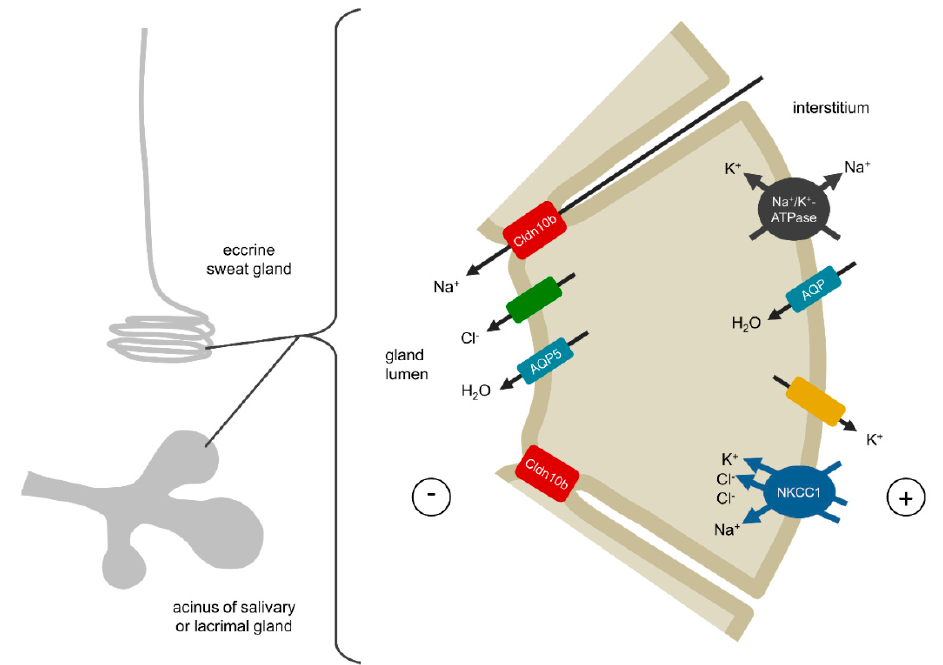
Figure 4. Mechanisms of claudin-10b function in the secretory portion of sweat glands and the acinar cells of salivary and lacrimal glands. During secretion, apical Cl – channels and basolateral K + channels are activated. Na + , 2 Cl – and K + enter the cell via the basolaterally expressed NKCC1 transporter. Cl – is secreted into the lumen whereas Na + and K + leave the cell basolaterally. The secretion of Cl – drives Na + transport via the paracellular claudin-10b channel and transcellular water transport via aquaporins. An abrogation of the claudin-10b-mediated Na + transport would result in a complete dysfunction of sweat, saliva and tear secretion.